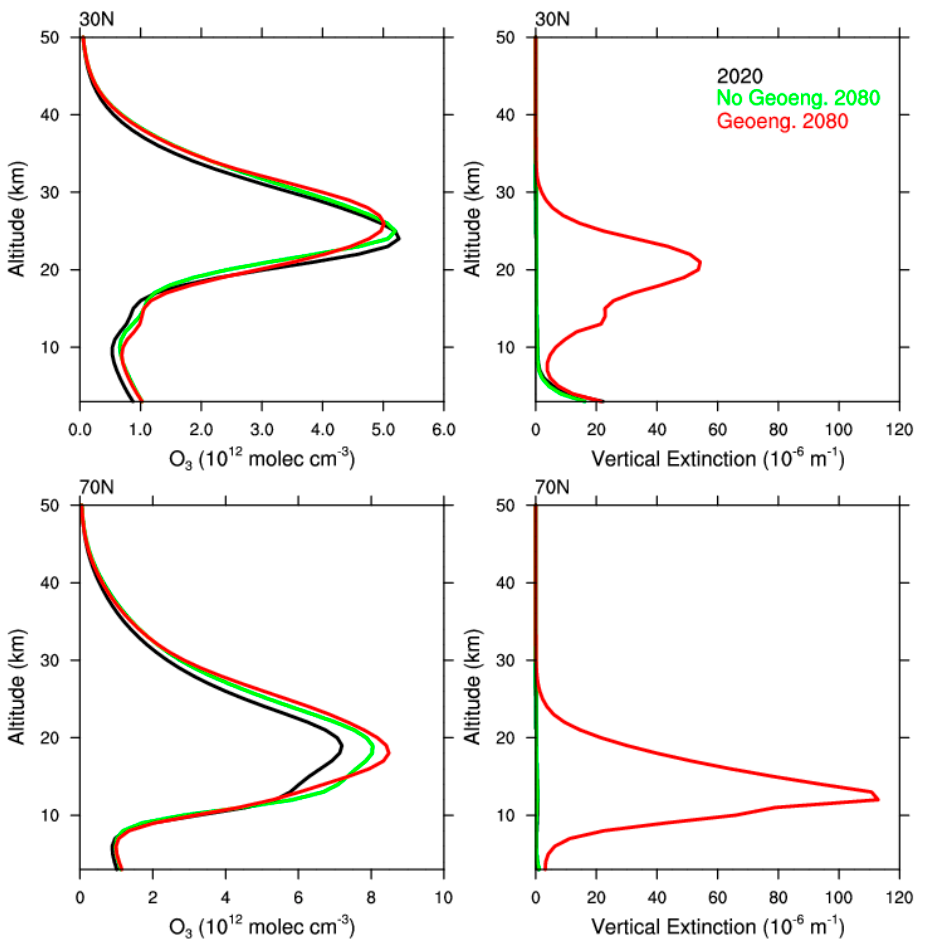
Figure 2. The vertical profiles of O 3 concentration ( left ) and sulfate aerosol extinction at 550 nm ( right ), zonally averaged at 30 N ( top ) and 70 N ( bottom ). The legend indicates the years depicted, all of which present March average data, for current day (2020) and future (2080) scenarios without and with geoengineering.